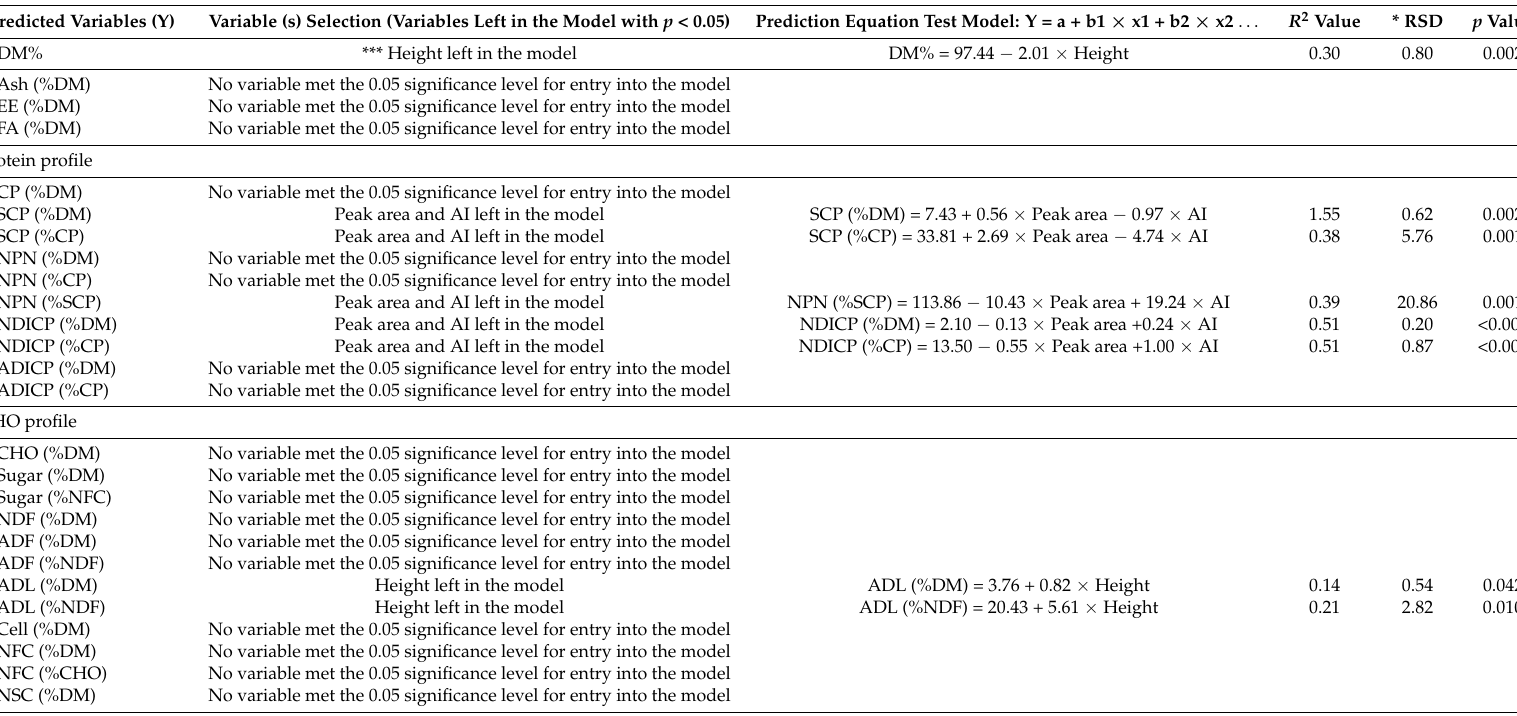
Table 11. Multiple regression analyses to find the important protein structural variables for predicting chemical profiles of canola seeds. Predicted Variables (Y) Variable (s) Selection (Variables Left in the Model with p <